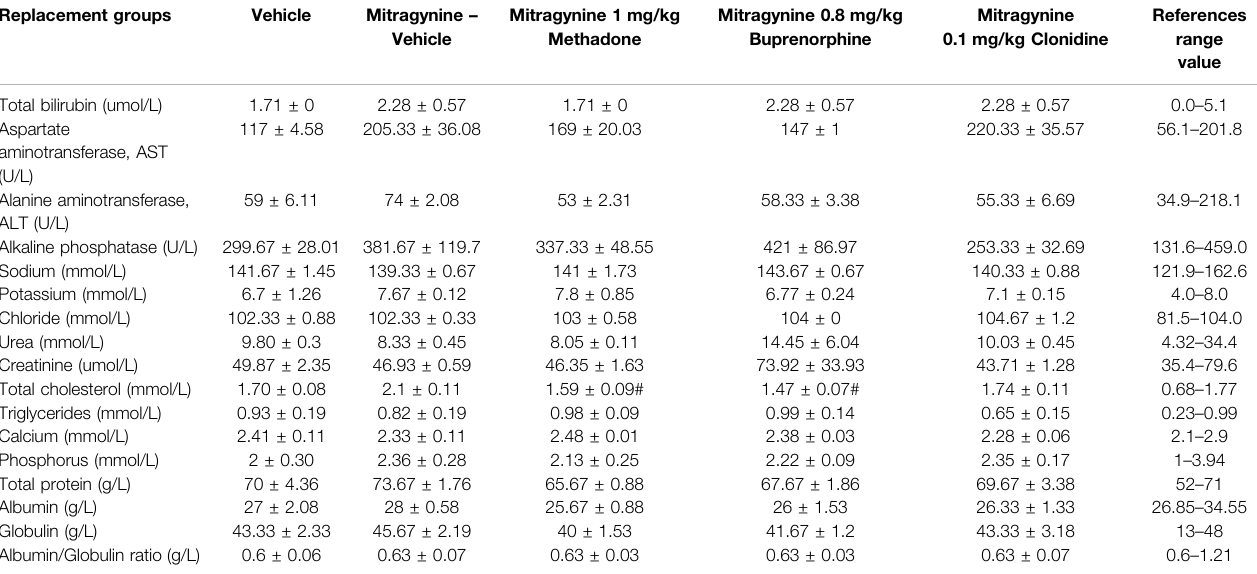
TABLE 3 | Biological analysis on day 5 in mitragynine replacement treatments. Replacement